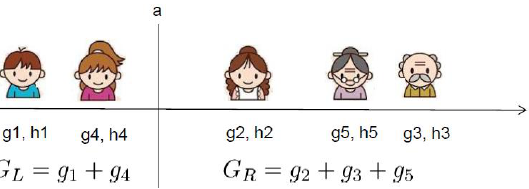
Figure A3. Optimal division by linear scanning. Source: Chen and Guestrin (2016).